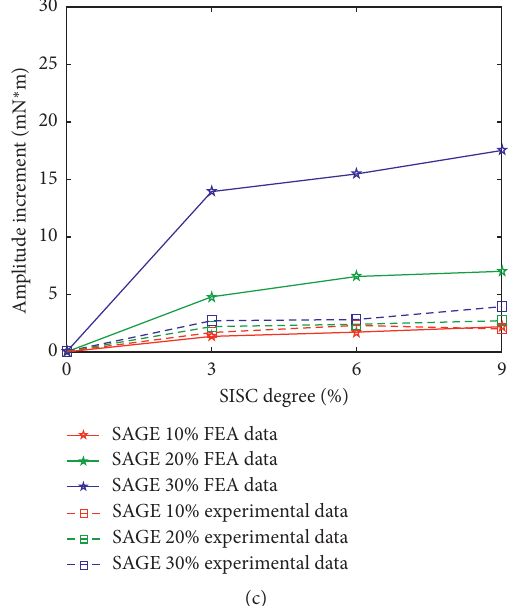
Figure 14: FEA and experiment comparison in CF cases with increased SAGE: (a) 2nd harmonic, (b) 4th harmonic, and (c) 6th